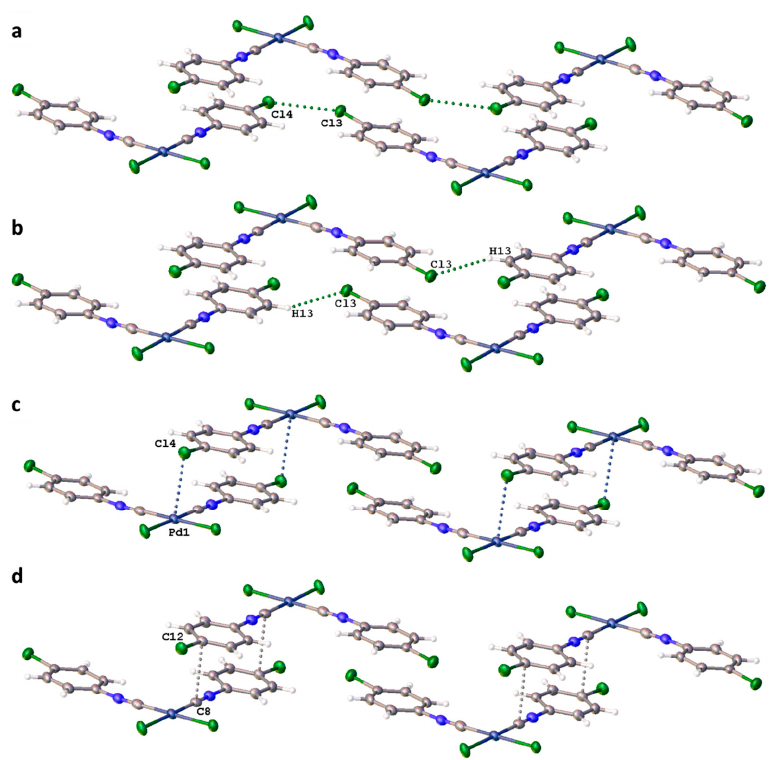
Figure 2. Noncovalent interactions in 1 . Dotted line indicates the C–Cl ··· Cl’–C HaBs ( a ), C-H ··· Cl-C hydrogen bonds ( b ), Cl ··· Pd semicoordination ( c ), and C ··· C contacts ( d ). All other crystal structures look similar, and they are reported in Figures S2 and S3 (Supporting